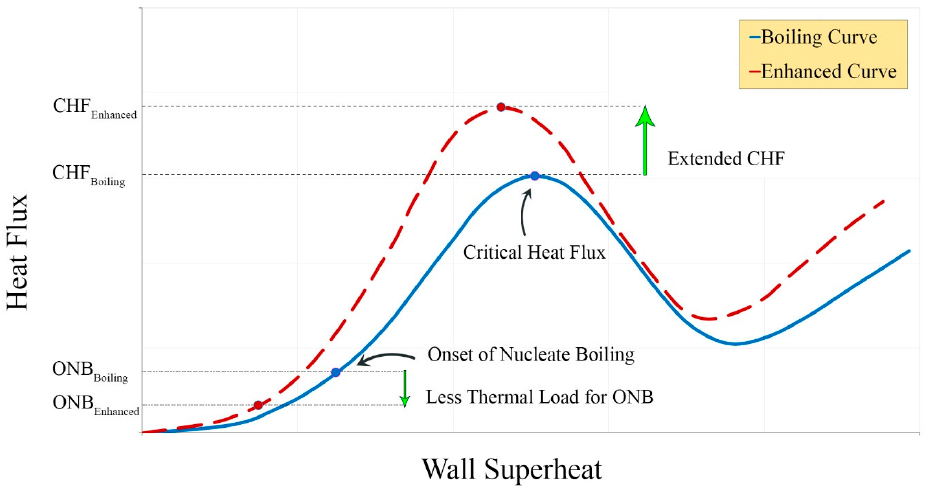
Figure 1. Comparison between common and ameliorated pool boiling curves.